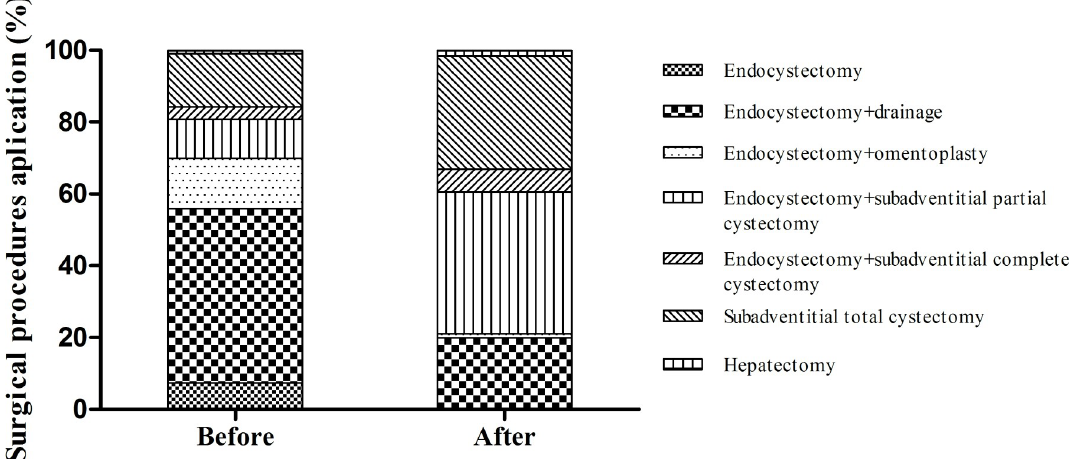
Fig 7. The proportion of patients undergoing radical surgery was reduced after program implementation. Endocystectomy and its derivatives (drainage; omentoplasty) decreased after program implementation; especially the sole use of endocystectomy (0%). Radical surgery, especially subadventitial (total and complete) cystectomy, increased. ( � p < 0.001 by the chi-square test). Exclusion criteria: (1) patients with hepatic cystic echinococcosis who underwent emer- gency surgery (most of whom had hydatid complications, such as rupture);(2) patients who